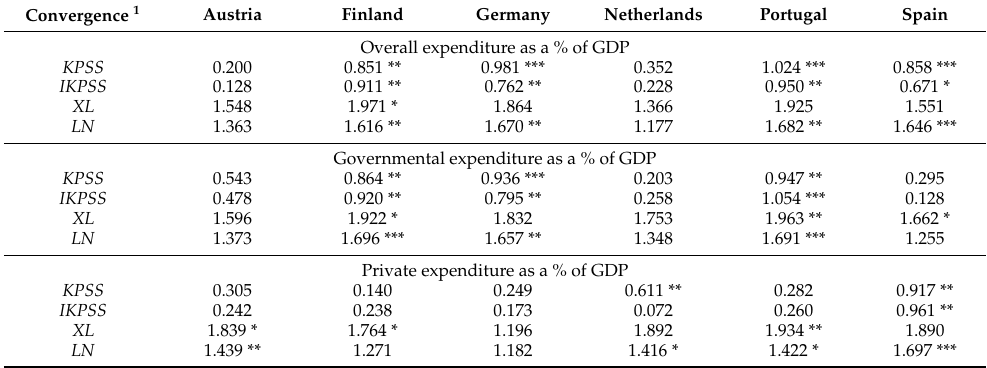
Table 5. Results of the tests for strict stationarity—health expenditure as a % of GDP. Convergence